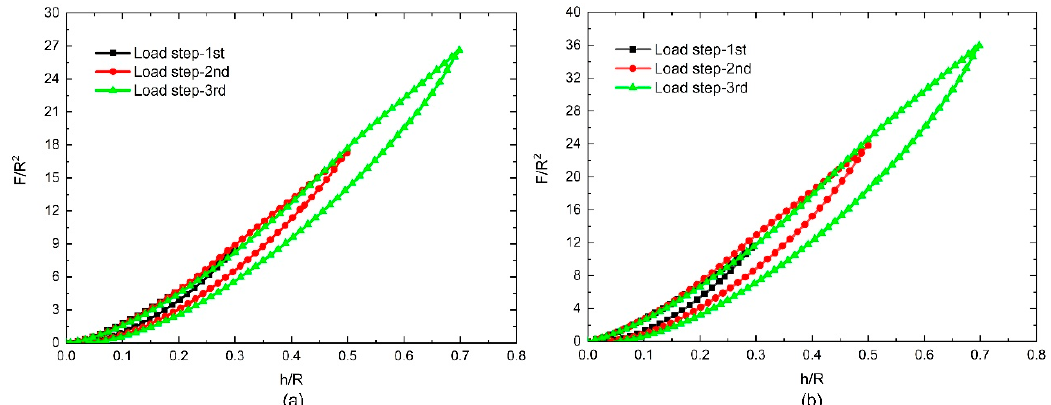
Figure 3. Corrected test results for the unfilled polyurethanes (UFPUs) subjected to cyclic compressive loads.